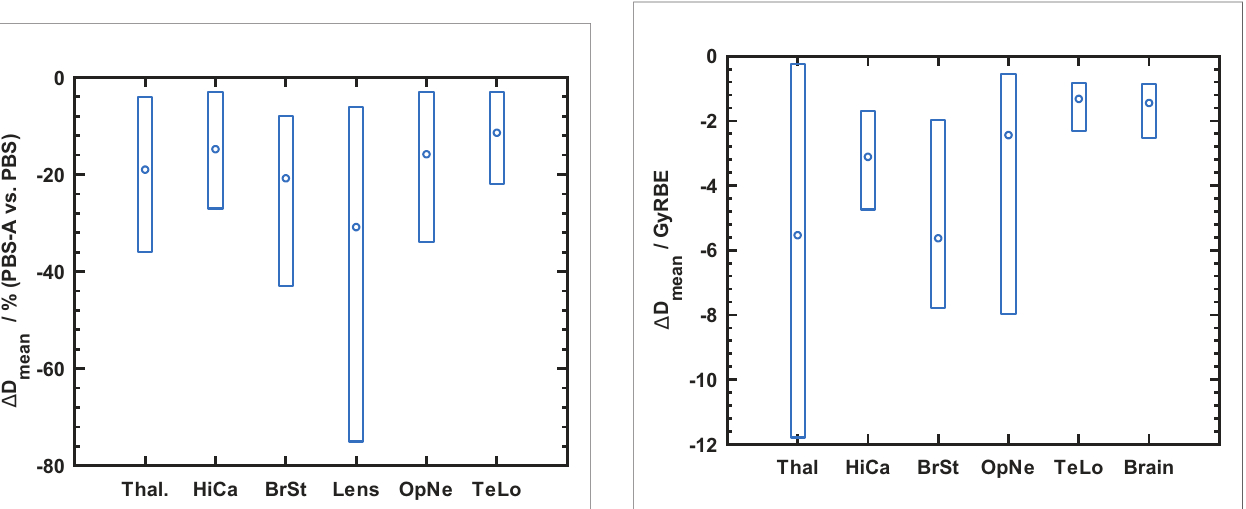
FIGURE 4 | Dose reduction to organs-at-risk (OAR) for craniopharyngioma cases comparing plans with aperture ( “ PBS-A ” ) with uncollimated plans ( “ PBS ” ). Percentage difference of D mean for organs-at-risk between the plans with and without apertures. The boxes show the full range of achieved reductions. The shown structures are Thal, thalamus; HiCa, hippocampus; BrSt, brainstem; OpNe, optical nerve; TeLo, temporal lobe; and